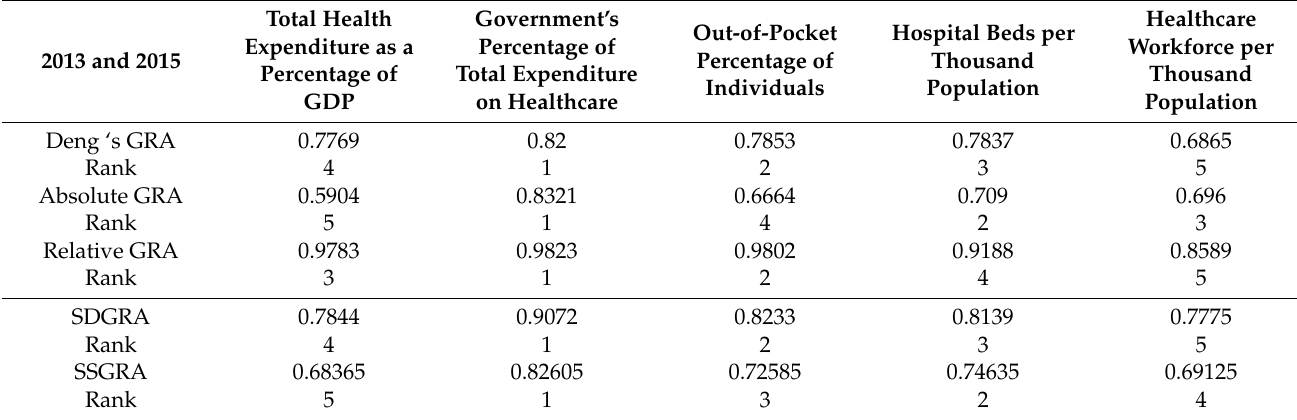
Table 2. Grey Relation Degree and Ranking of the Healthcare Resource Factors for Public Satisfaction with Health System in China (Year 2013 and 2015).